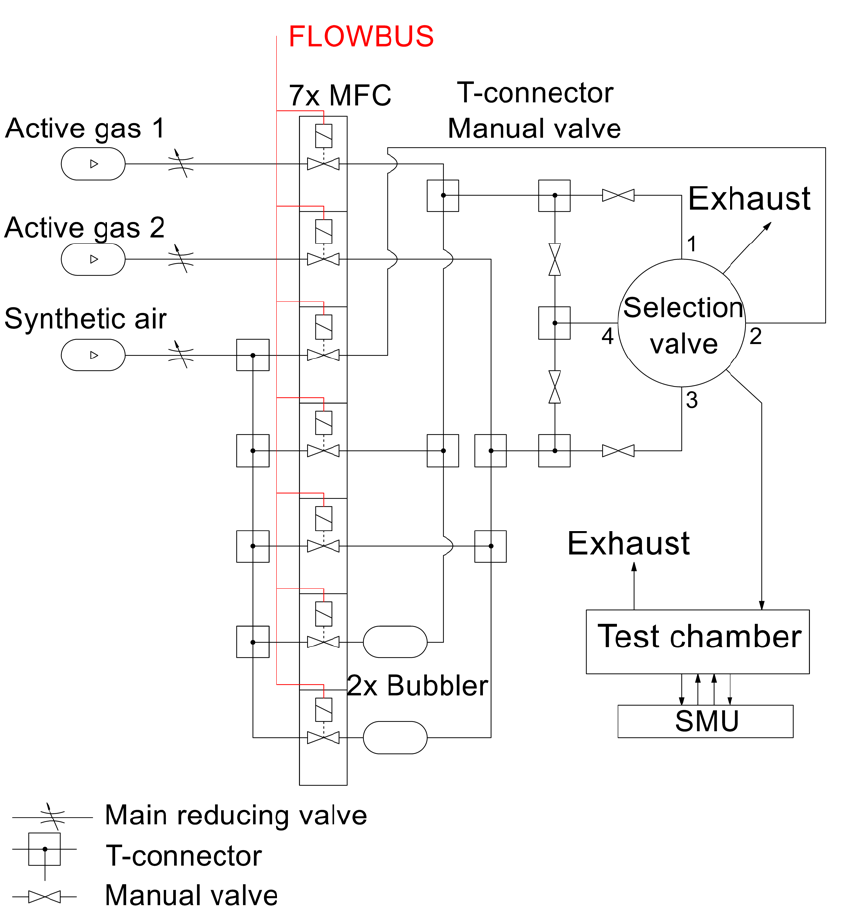
Figure 1. Schematic diagram of experimental setup for gas sensor testing.